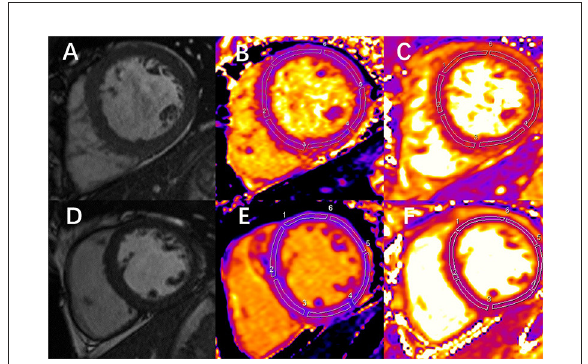
FIGURE1 Examples of end-diastolic cine images and corresponding measurement of native T1 and T2 in 1 chronic kidney disease (CKD) patient and 1 healthy control. (A) Image shows the left ventricular middle short-axis segment. (B,C) Images are the measurement of native T1 and T2 mapping, respectively, at the same slice position in the same patient. (A-C) Images correspond to a 49-year-old CKD male patient. The mean global T1 value is 1,061ms, and the mean global T2 value is 52ms. (D) Image shows the left ventricular middle short-axis segment. (E,F) Images are the measurement of native T1 and T2 mapping, respectively, at the same slice position in the same person. (D-F) Images correspond to a 32-year-old healthy volunteer. The mean global T1 value is 1,003ms, and the mean global T2 value is 45